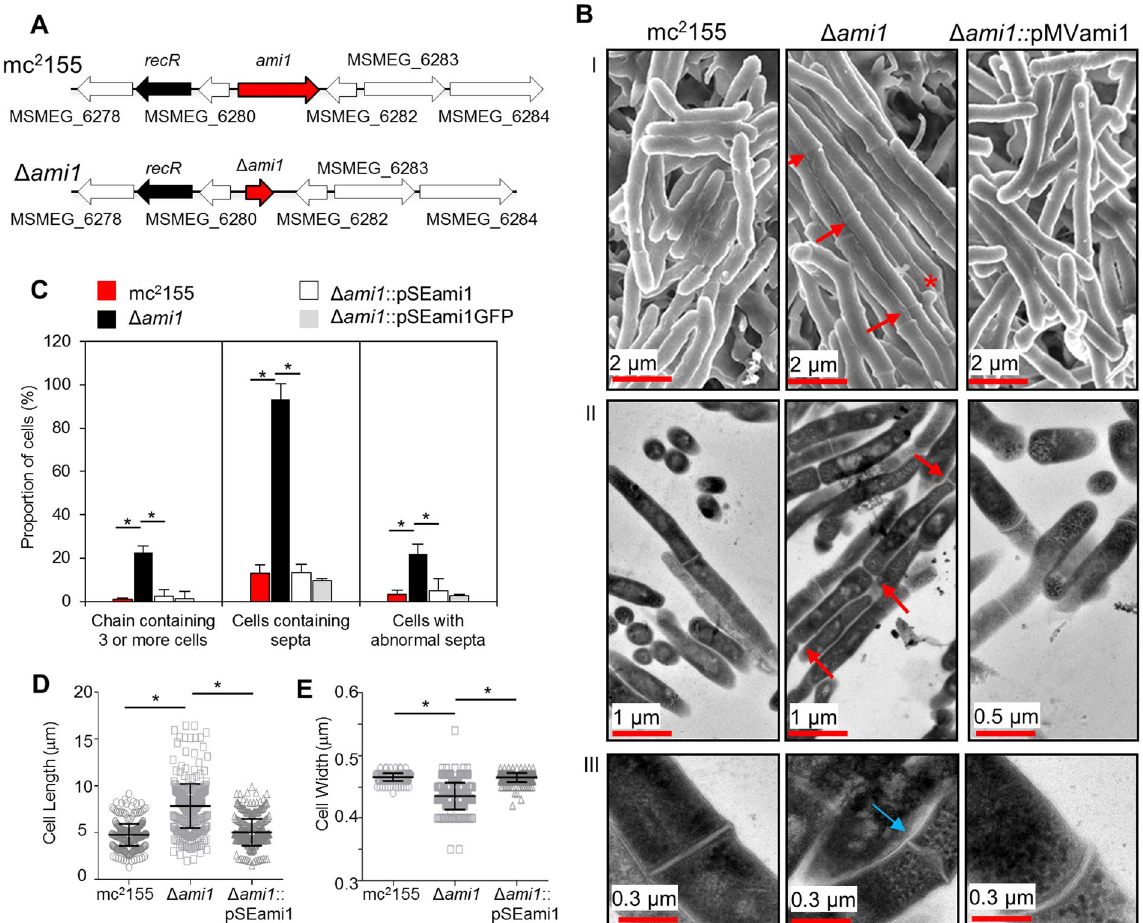
Figure 1. Phenotypic analysis of the Δ ami1 mutant. ( A ) Genomic map of the Δ ami1 deletion mutant. ( B ) (I) Scanning electron microscopy of the mc 2 155, Δ ami1 and Δ ami1 ::pSEami1 strains depicting cell chaining, shown by the red arrows, as well as the occurrence of lateral buds ( * ). (II) and (III) Transmission electron microscopy to confirm synthesis of the septum in cell chains indicated by the red arrow as well as the formation of abnormal septa indicated by the blue arrow. ( C ) Histogram depicting the proportion of cells which chaining, arrested septation and aberrant septal structures (n = 400), * p < 0.0001. ( D,E ) scatter plots displaying the change in mean cell length and width respectively in the Δ ami1 strain. Scale = 5 µ m. Approximately 400 cells for each strain were assessed, p-values are the results of a student’s